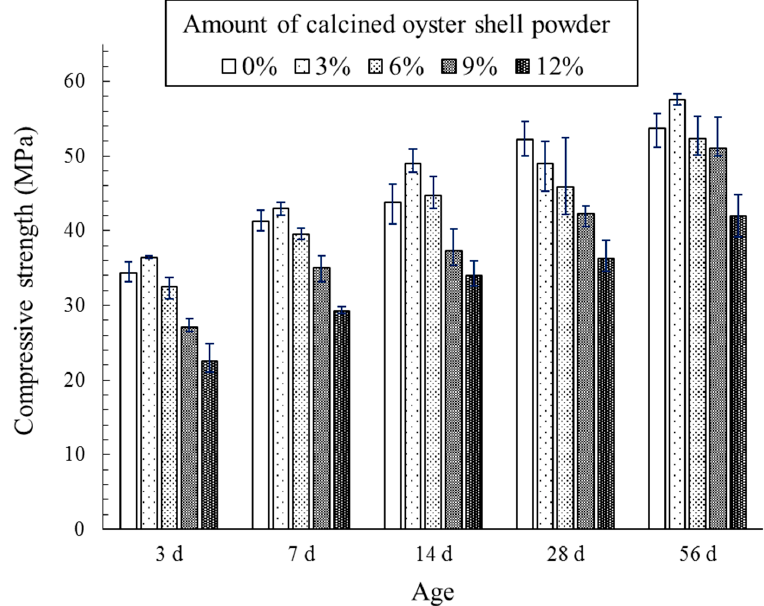
Figure 6. Effect of calcined oyster shell powder addition on the compressive strength development of cement mortar. cement